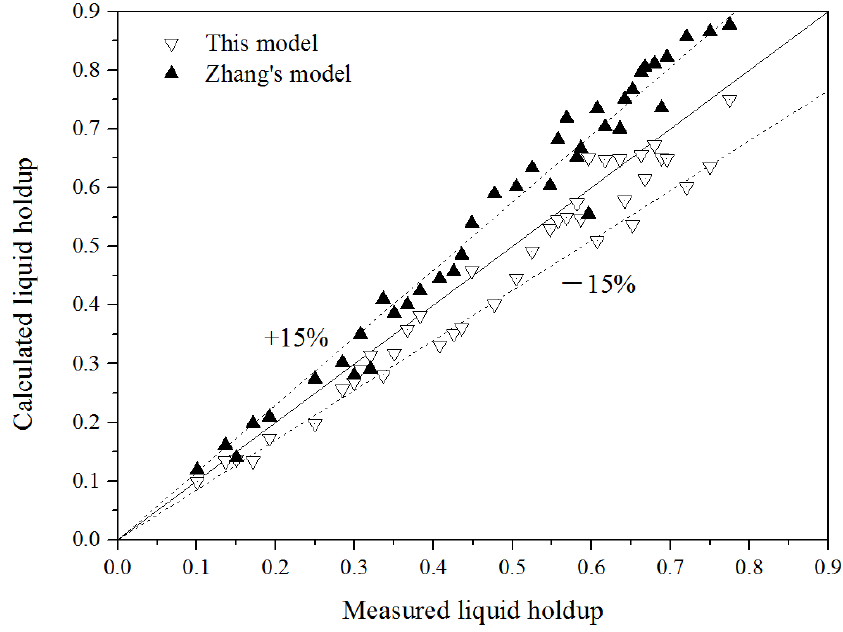
Figure 8. Comparison of liquid holdup between the two models for the No. 3 experiment.